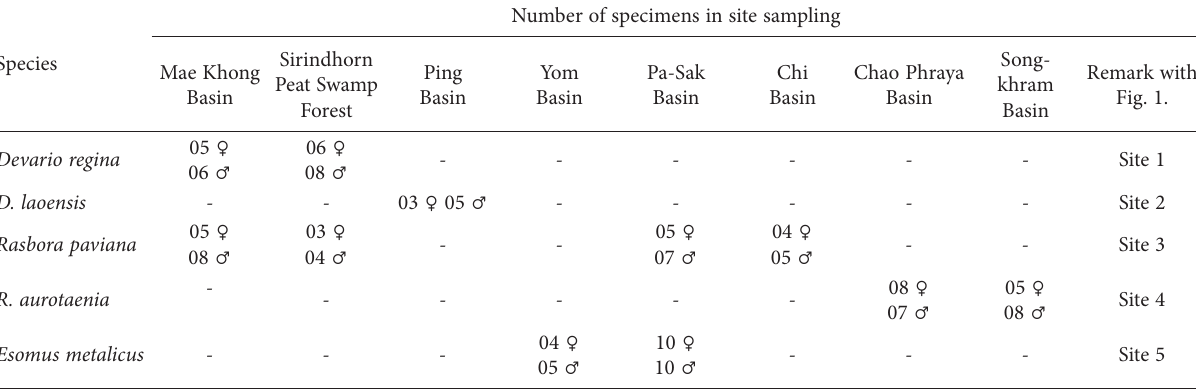
Number of specimens in site sampling